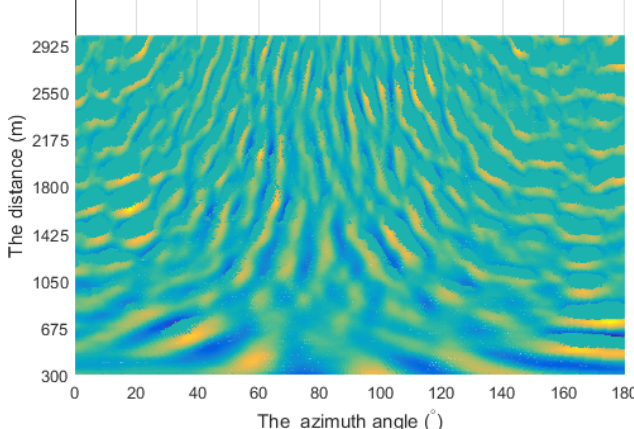
Figure 2. The simulated marine radar image in Cartesian